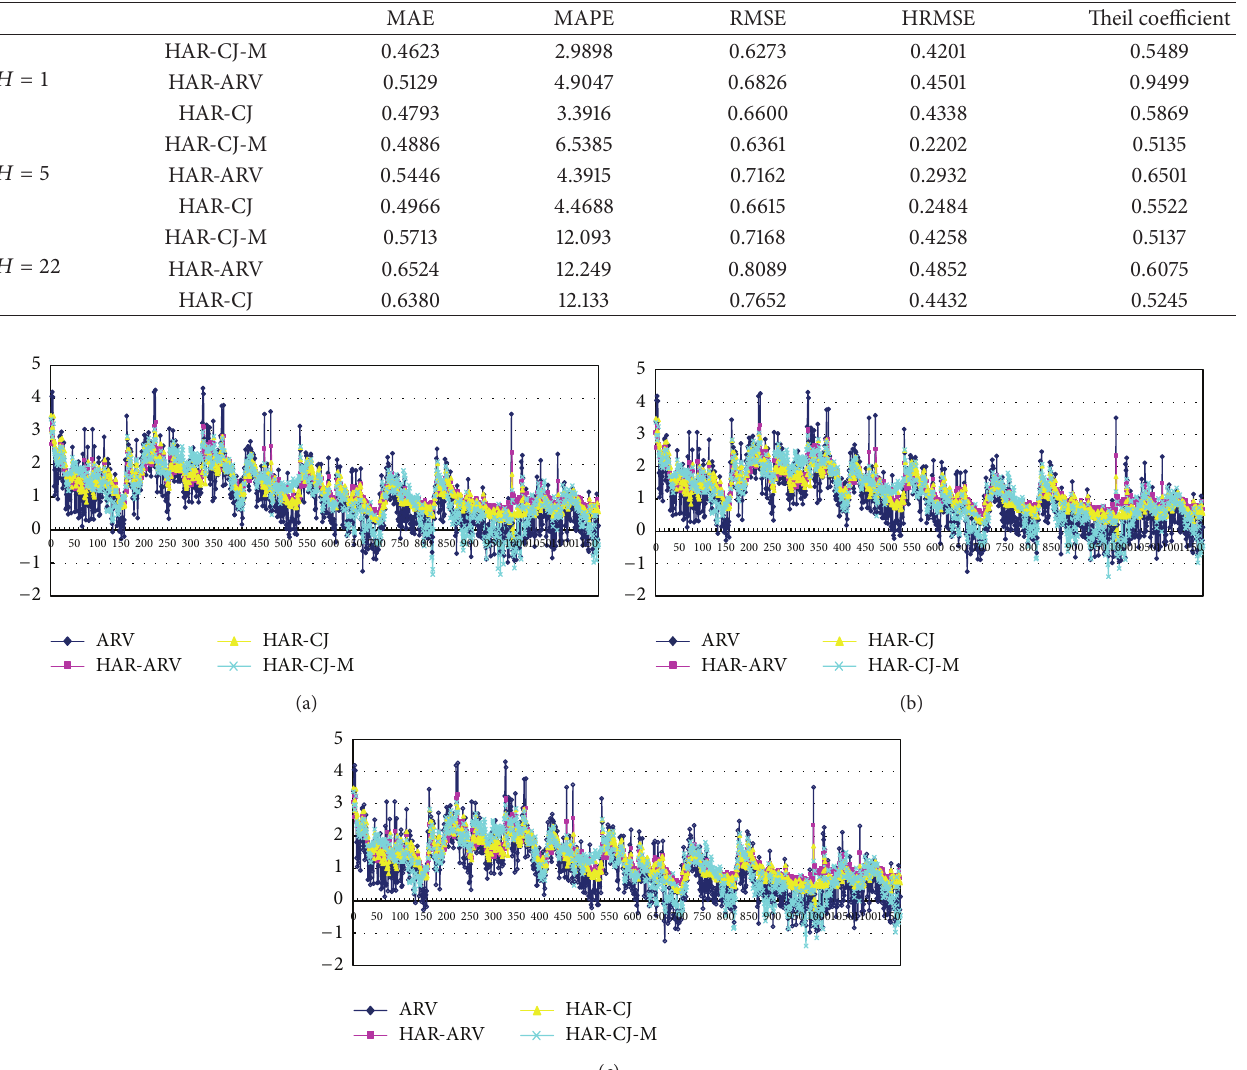
Table 7: Out-of-sample Forecast Statistics.